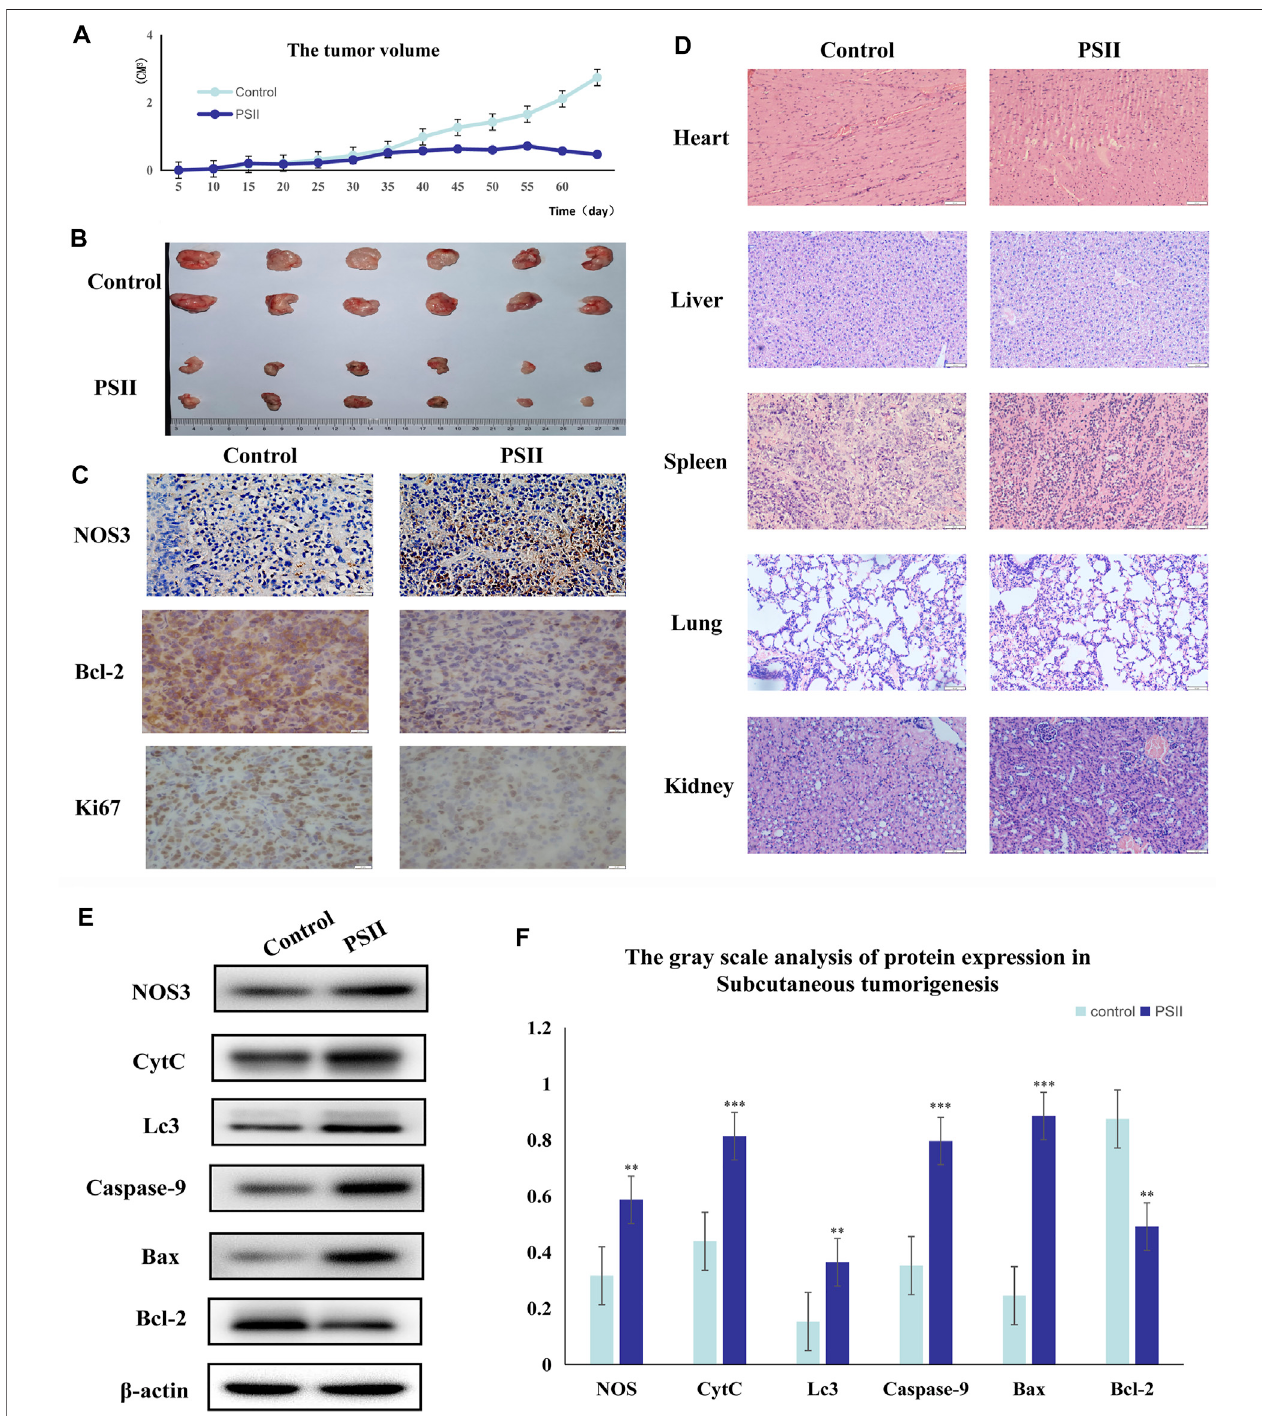
FIGURE 10 | Suppression of tumorigenesis in a xenograft model. (A) Growth curves of the volumes of xenograft tumors after the injection of Tu686 cells. (B) The representative tumor pictures. (C) IHC analysis of NOS3, Bcl-2, and Ki67. (D) Histopathological examination of the lung, heart, kidney, liver, and spleen. (E) The protein expression oftumorigenesisinaxenograftmodelbyWesternblotanalysis. (F) ThegrayscaleanalysisofproteinexpressioninTu686cellsbyWesternblot.Bars,50 µm. All the experiments were carried out three times. The bar graphs and the table show quanti fi cation of the results, and each data represent the mean ± SD of three independent experiments (* p < 0.05; ** p < 0.01; *** p < 0.001 vs the control group).